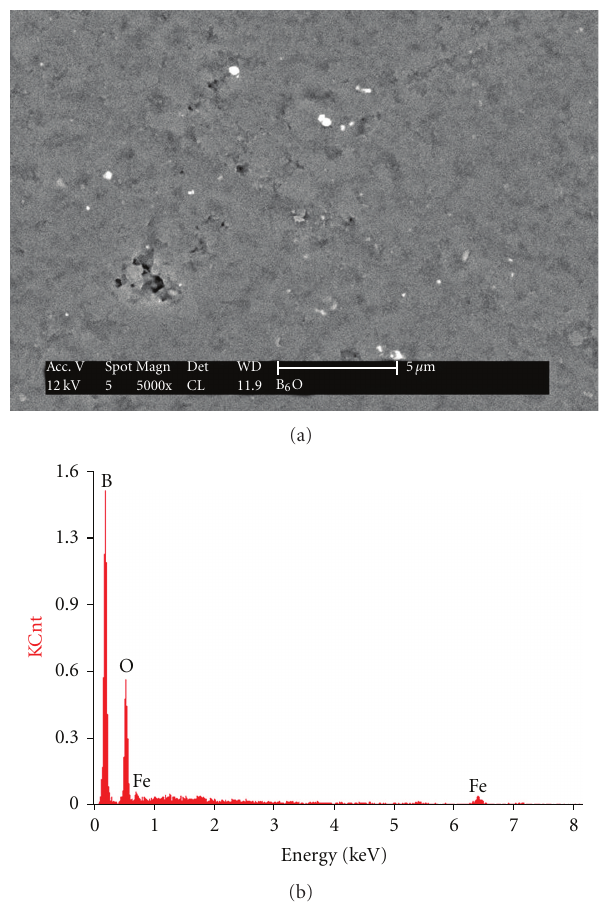
Figure 1: It shows the SEM surface micrograph (a) and the EDX surface compositional analysis (b) of the hot-pressed B 6 O specimen. Iron contamination (bright spots on SEM micrograph) is responsible for EDX elemental peaks